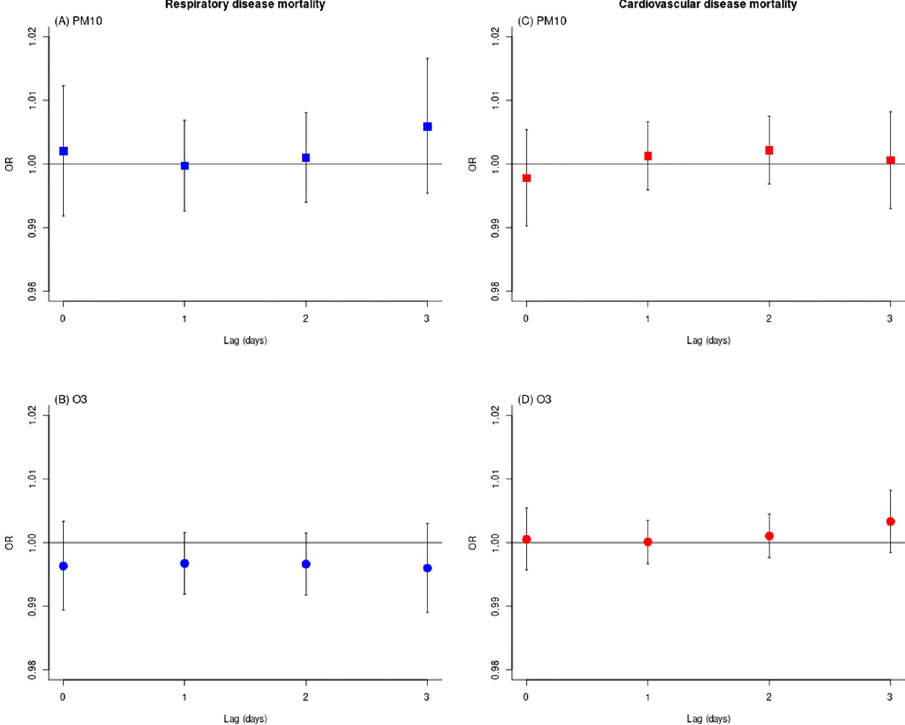
Fig 1. Lag-specific association of short-term exposure to PM10 and O3, and respiratory (A-B) and cardiovascular disease mortality (C-D), Rio de Janeiro (Brazil) (2012–2017). PM10: Particulate matter � 10 μ m; O3: Ozone; OR: Odds